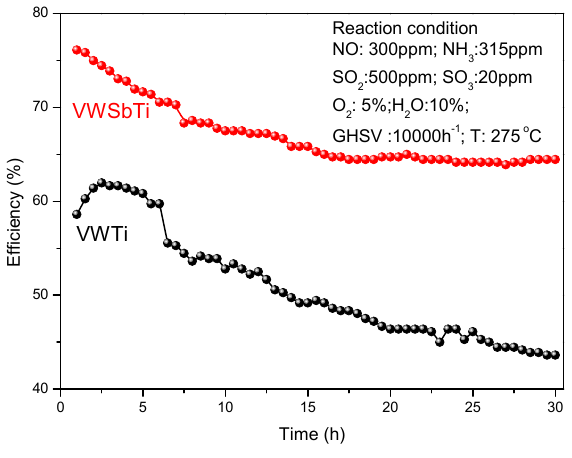
Figure 2. Stability tests for catalysts.